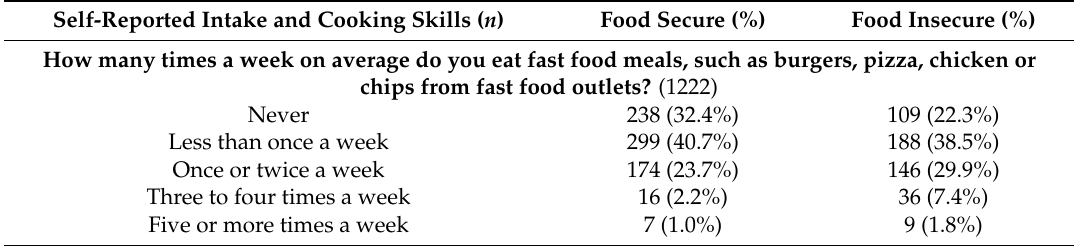
Table 4. Self-reported dietary intake and cooking skills of participants attending the Food Sensations ® for Adults programs between May 2016 and April